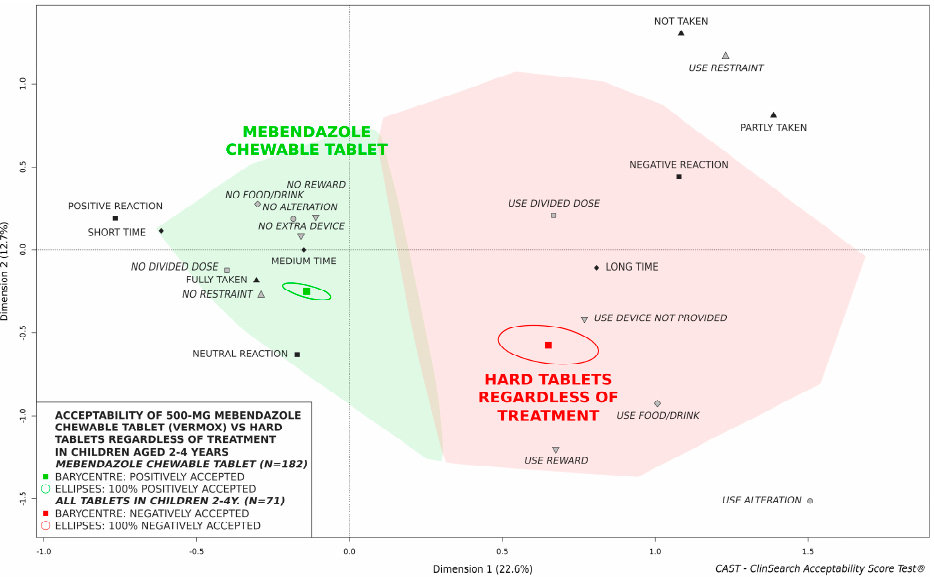
Figure 2. Acceptability of 500-mg mebendazole chewable tablet compared with tablets regardless of treatment in children aged 2 to 4 years.